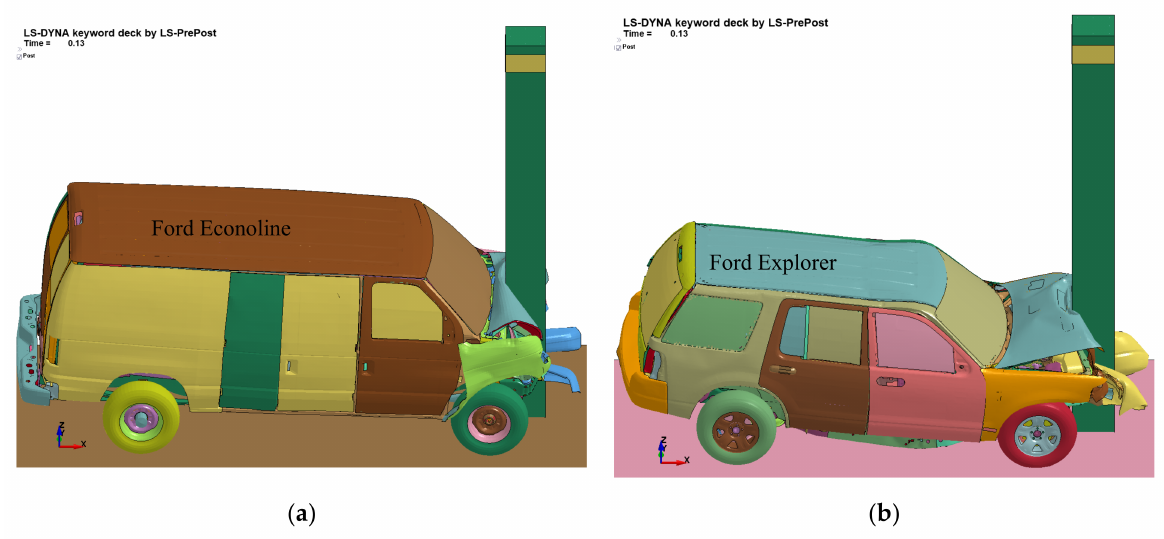
Figure 8. Damage to the car during the collision against the column (column width 400 mm and V = 40 km/h): ( a ) Ford Econoline car–column collision; ( b ) Ford Explorer car–column